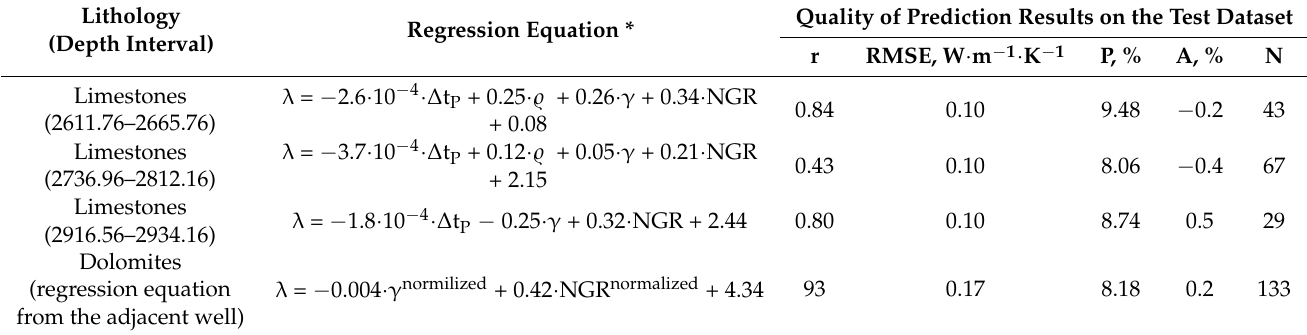
Table 5. The results of training and testing regression models for determining rock thermal conductivity from well-logging. Lithology Regression Equation *